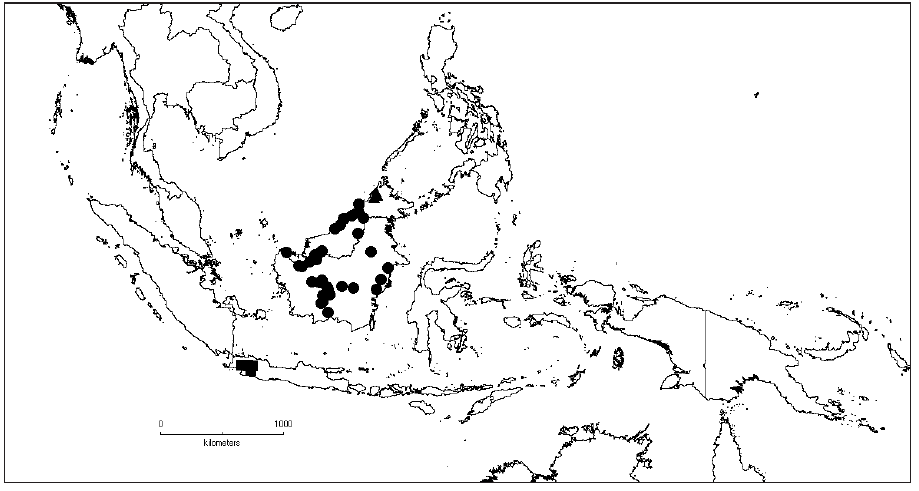
Map 25. Distribution of D. rostrata ( ● ), D. rubiginosa ( ▲ ) and D. sagittata ( ■